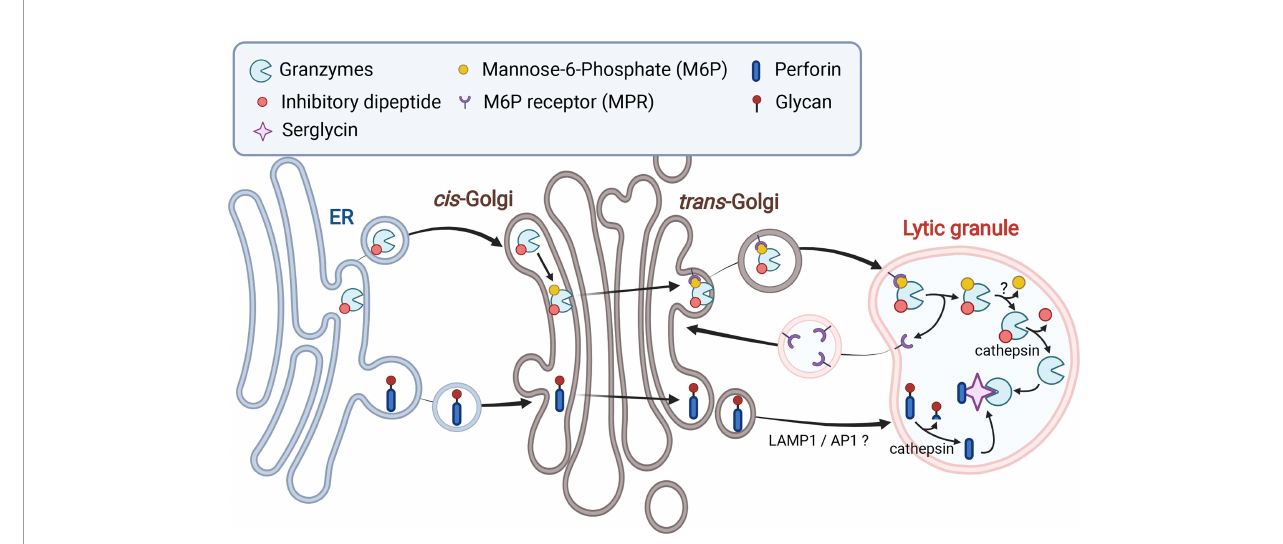
FIGURE 1 | Biosynthesis and traf fi cking of granzymes and perforin to lytic granules. Both granzymes and perforin are translated into the ER and traf fi cked to the Golgi. Addition of mannose-6-phosphate (M6P) to granzymes facilitates transport of granzymes to lytic granules (LGs) via M6P receptors. Transport of perforin to LGs is mediated by LAMP1 and adaptor protein 1 (AP1) sorting complex via an unknown mechanism. Both perforin and granzymes are processed into active forms by cathepsins and other proteases in the LGs but maintained in an inactive state via their association with